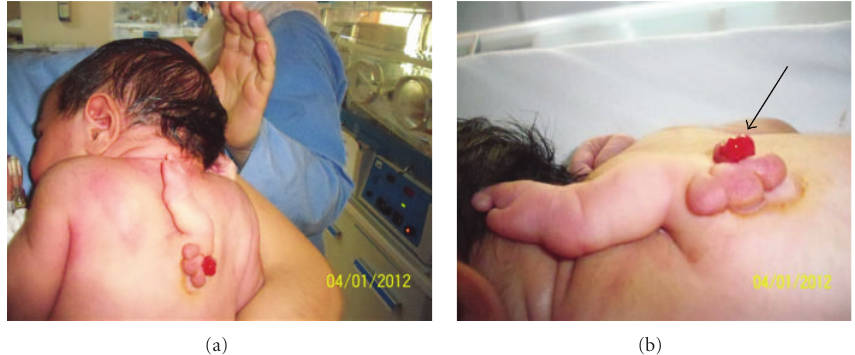
Figure 1: A malformed accessory arm attached to the back; it is immobile. There are three small buds originating from just below the root of the arm (a). Note that hemorrhagic area is located caudal to this accessory extremity (arrow).